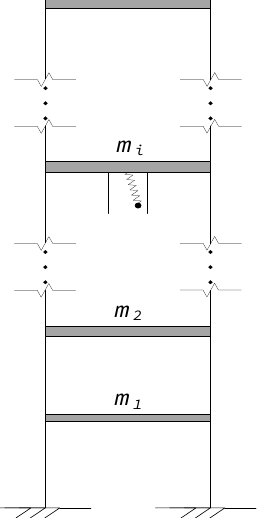
Figure 6. Schematic of the structure-SPPTMD system.